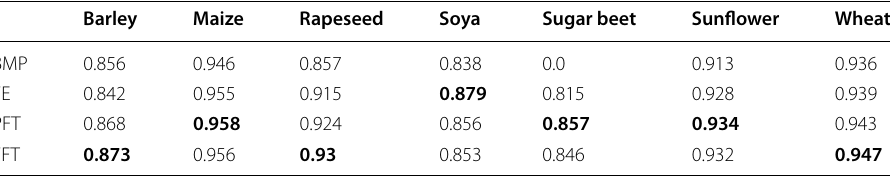
Highest performing values are highlighted in bold